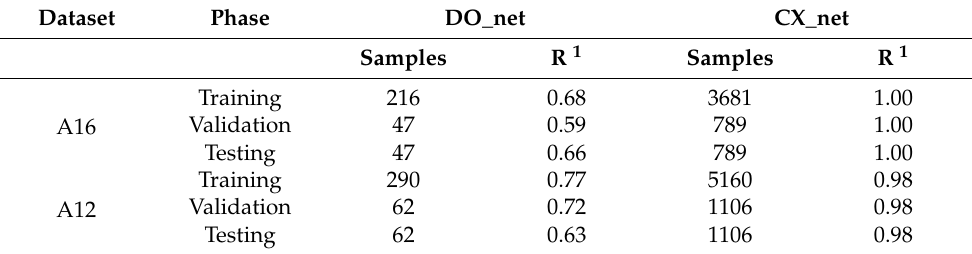
Table 3. Results for the neural networks building phases (training, validation, and test). A16 dataset was used for fuzzy controller initial performance test, and A12 dataset was used for further robustness